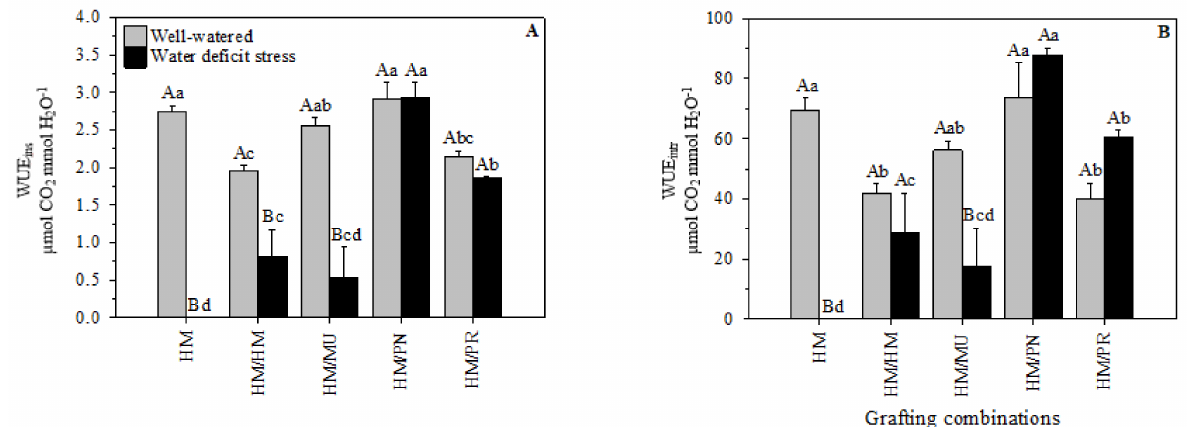
Figure 5. ( A ) Instantaneous leaf water use efficiency (WUE ins ) and ( B ) intrinsic leaf water use efficiency (WUE intr ) of five grafting combinations under well-watered and water-deficit stress conditions. Capital letters denote significant differences between water regimes within each graft combination and lower-case letters denote significant differences among grafting combinations within each water regime according to the LSD test ( p ≤ 0.05). Columns are mean ± standard error. Note: HM = non-grafted HM 1823; HM/HM = HM 1823 self-grafted; HM/MU = HM 1823 grafted onto Multifort; HM/PN = HM 1823 grafted onto S. pennellii ; and HM/PR = HM 1823 grafted onto S. peruvianum